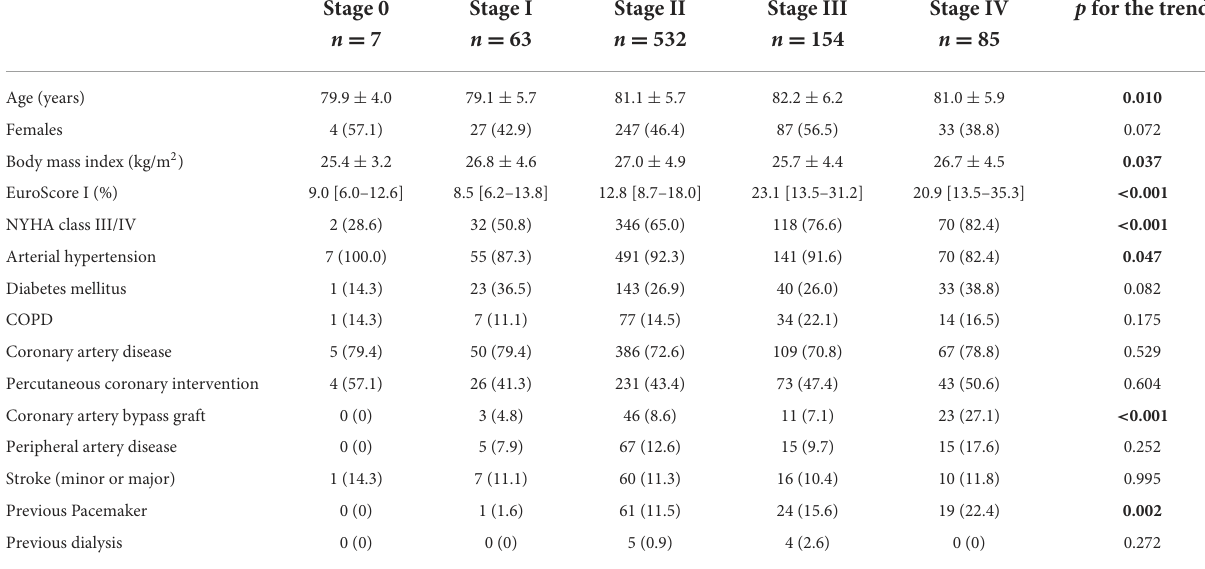
TABLE 1 Baseline characteristics according to stages of cardiac